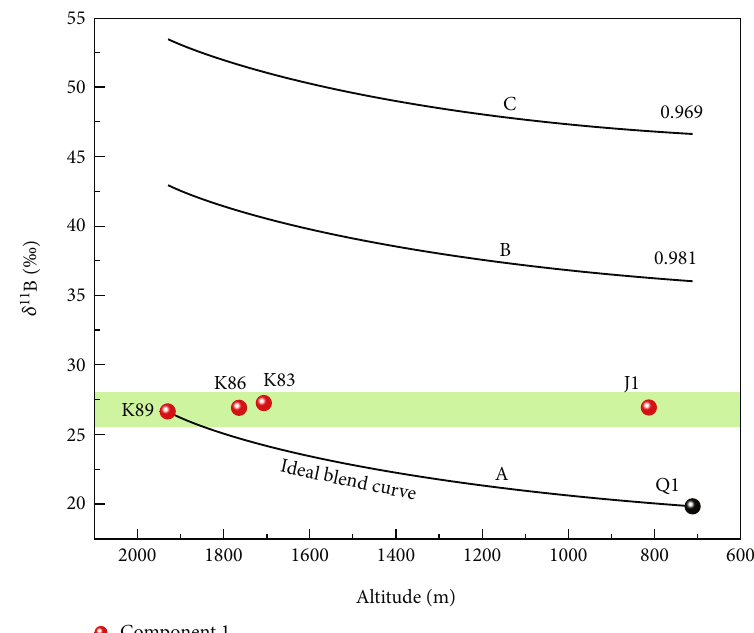
Figure 6: Relationship between the δ 11 B values and the altitude of water sampling sites in the northwestern margin of the Kumish basin, J1 and the Uzong spring water samples